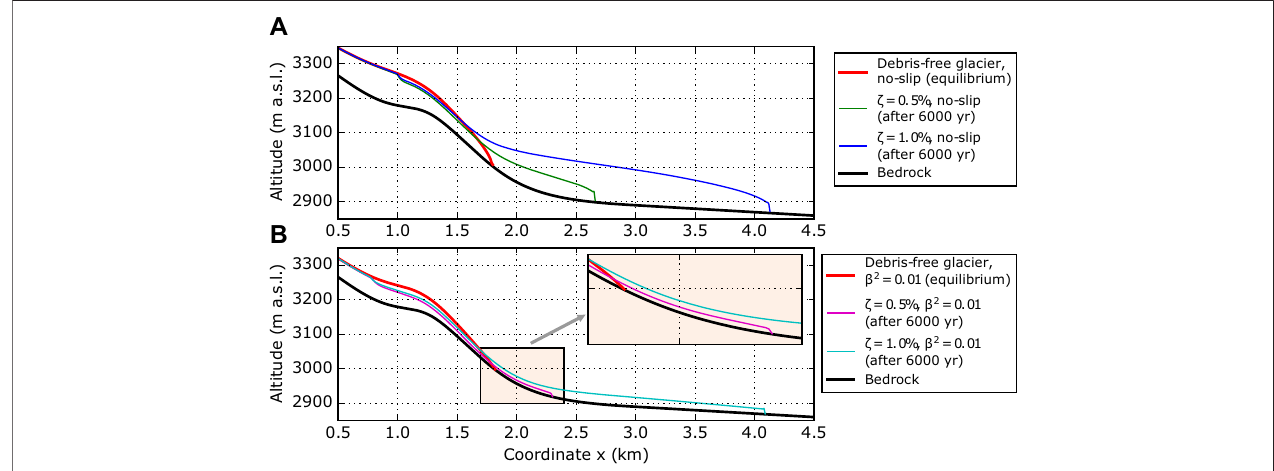
FIGURE4| Modelledevolution ofglaciergeometry forcleanand debris-covered glaciersincase of (A) no-slipand (B) slidingconditionsat theglacier base.Clean- ice equilibriumstates(red) arecompared withdebris-coveredstates after6,000 years(not inequilibrium). Glacierswithhigher debrisconcentration( ζ (cid:1) 1.0%) arelonger (blue and cyan). On the other side, basal sliding reduces the mean glacier thickness (magenta and cyan).